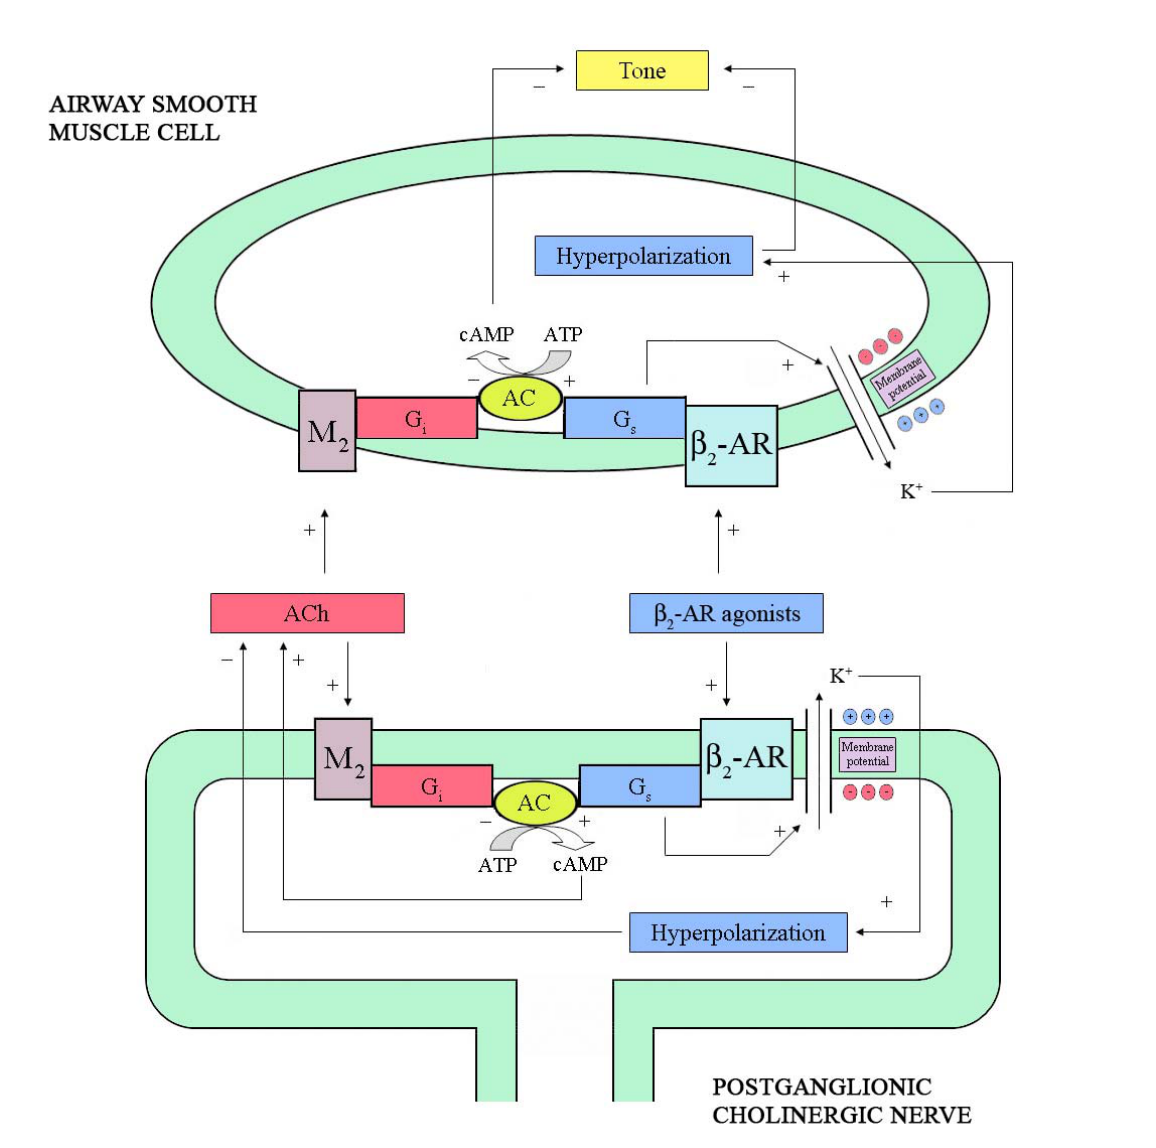
Figure 1. Pre- and post-junctional intracellular mechanisms modulating cholinergic neurotransmission and airway smooth muscle (ASM) cell tone. At pre-junctional level, -adrenoceptor ( β -AR) by agonists opens Ca 2+ -activated K + (BKCa) channels stimulation of β 2 2 leading to cell membrane hyperpolarization and reduction of acetylcholine (ACh) release. By contrast, direct activation of adenylyl cyclase (AC) enhances ACh release. In the ASM cell, -AR as well as direct stimulation of AC, opens BKCa channels determining cell stimulation of β 2 membrane hyperpolarization and relaxation. The ACh released by postganglionic cholinergic -muscarinic receptors expressed both at pre- and post-junctional level, thus nerves binds M 2 inhibiting ACh release and increasing ASM cell tone. cAMP: cyclic 3',5'-adenosine and G : stimulatory and inhibitory subunits monophosphate; ATP: adenosine trisphosphate; G s i of the receptor-coupled G-protein,